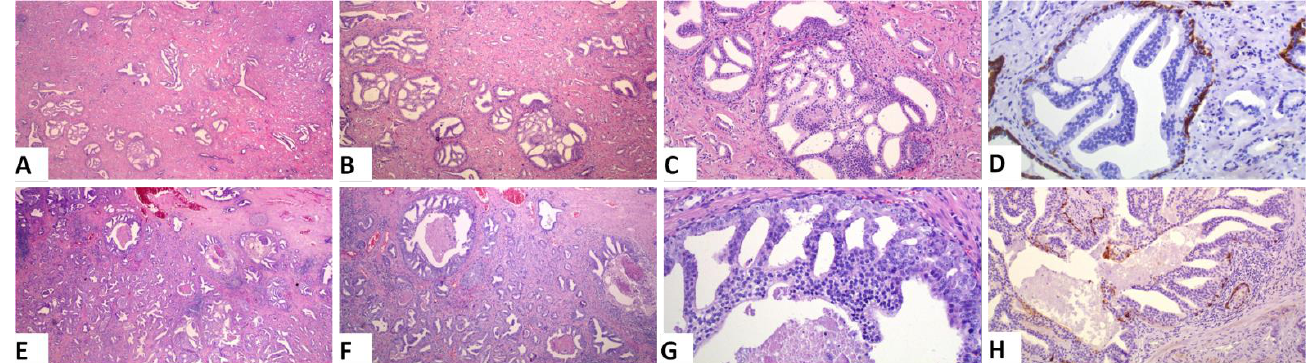
Figure 2. Representative images of the two cases that had a change in PGG when IDC was incorporated into grading: ( A – D ) A case with a high amount of IDC and an invasive carcinoma PGG2. Incorporation of IDC into grade will change the grade to 3. ( E – H ) A case with extensive IDC with comedo necrosis. Invasive carcinoma is PGG2 (7 3 + 4). Incorporation of IDC into grading will result in a significant upgrade to PGG5. (( A , E ): original magnification × 20; ( B , F ): original magnification × 40; ( C , G , H ): original magnification × 100; ( H ):original magnification × 200; ( D , H ): immunohistochemical staining with the basal cell marker 34bE12 cytokeratin).